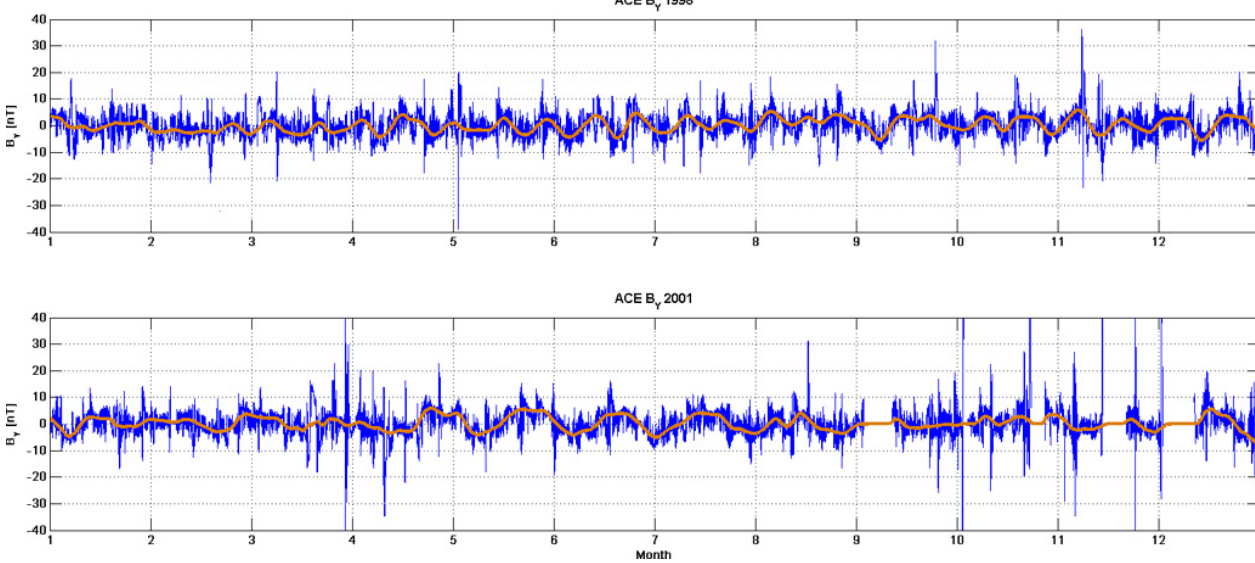
Fig. 2. The SS effect, displayed by the method of filtration with the 7-day averaging window and nonlinear smoothing (yellow line) and the original data series of the IMF B y measurements on board ACE spacecraft (blue line) for 1998 and 2001.